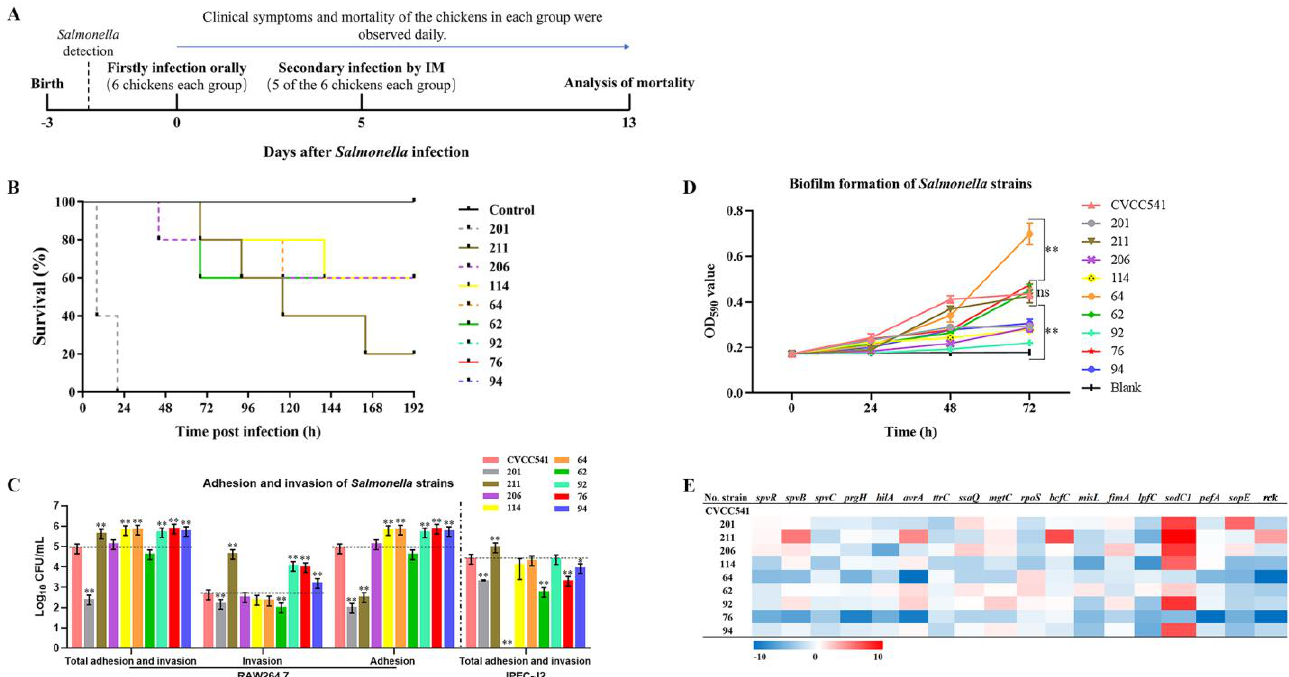
Figure 1. Basic virulence features of the nine S. enterica isolates. ( A , B ) Acute pathogenicity of the nine S. enterica isolates on chickens. ( A ) Design of Salmonella acute infection experiment. These newly hatched broiler chickens were firstly detected without Salmonella contamination, then orally infected by different Salmonella strains in 3 days old, respectively (six chickens each group). Five days post infection, five of the six chickens in each group were secondary infected by intramuscular injection (IM) and observed successively for 8 days. ( B ) Survival curves of these chickens following the infection procedures. The percentages of survival of the chickens infected by each strain were shown. No chicken survived after the infection of S. enterica isolate 201, and 20% of the chickens (one chicken) survived after the infection of 211. ( C ) Adhesion and invasion of S. enterica bacteria in macrophage (RAW264.7) and IEC (IPEC-J2). The Y-axis is the value of log 10 CFU/mL of each strain in the cells. ( D ) Biofilm formation of nine S. enterica strains at different time points growing in Luria-Bertani (LB) broth at 37 ◦ C. The Y-axis is the OD 590 value of crystal violet in biofilm. ( E ) The expression of 18 virulence genes in nine S. enterica strains isolated from chicken. Horizontal axis represents S. enterica strains, one detected gene for one column, red means highly expressed genes, and blue means low expression genes. * p ≤ 0.05, ** p ≤ 0.01 by one-way analysis of variance (ANOVA) plus Dunnet’s multiple comparison tests compared with CVCC541 in each group respectively; Blank, negative control; Bar, means ± SD; n =